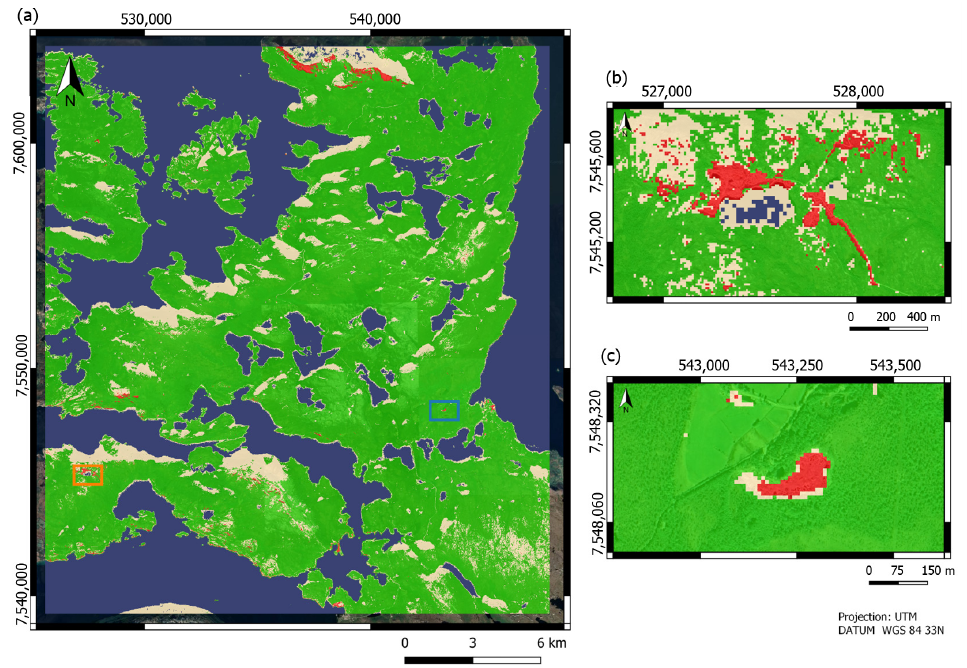
Figure 21. LGB classifier. Pegmatites are classified as red colour, granite as beige, water as blue, and vegetation as green ( a ) Overview of the study area where Håkonhals mine is highlighted by the orange rectangle and Jennyhaugen mine by the blue rectangle. ( b ) Håkonhals mine in focus. ( c ) Jennyhaugen mine in focus.